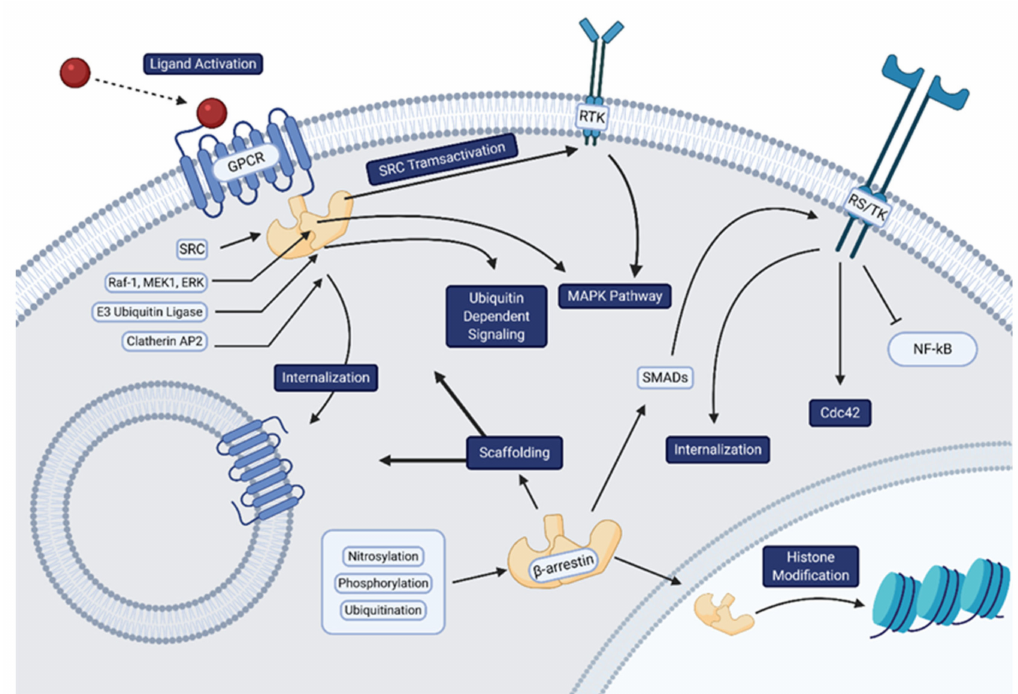
Figure 1. Overview of β -arrestin-mediated signaling. β -arrestins orchestrate a variety of cellular processes in addition to their originally discovered function of “arresting” GPCR signaling. These direct effects on membrane receptors such as internalization of GPCRs and transactivation of RTK and RS/TKs. β -arrestins can also promote their own signaling via scaffolding of several proteins (i.e MAPKs, Src, and clathrin), undergo various modifications such as ubiquitination, and influence epigenetic modifications. Created with